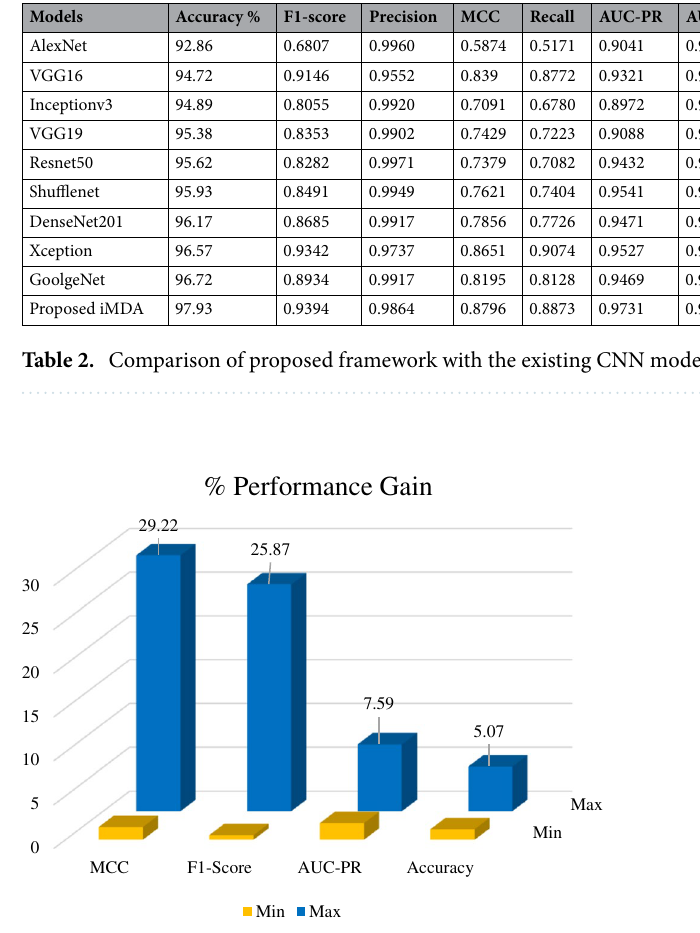
Figure 6. Minimum and maximum performance gain of proposed